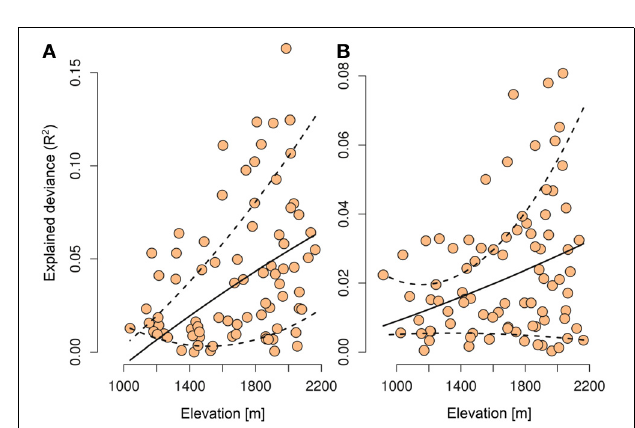
species is found and the explained deviance of the models when only the number of OTUs is included in the species distribution models. Shown are the results with Glomeromycetes (A) and Agaricomycetes (B) when considered alone as predictor in the species distribution models. The dashed lines represent the 10th and 90th percentile confidence interval from quantile